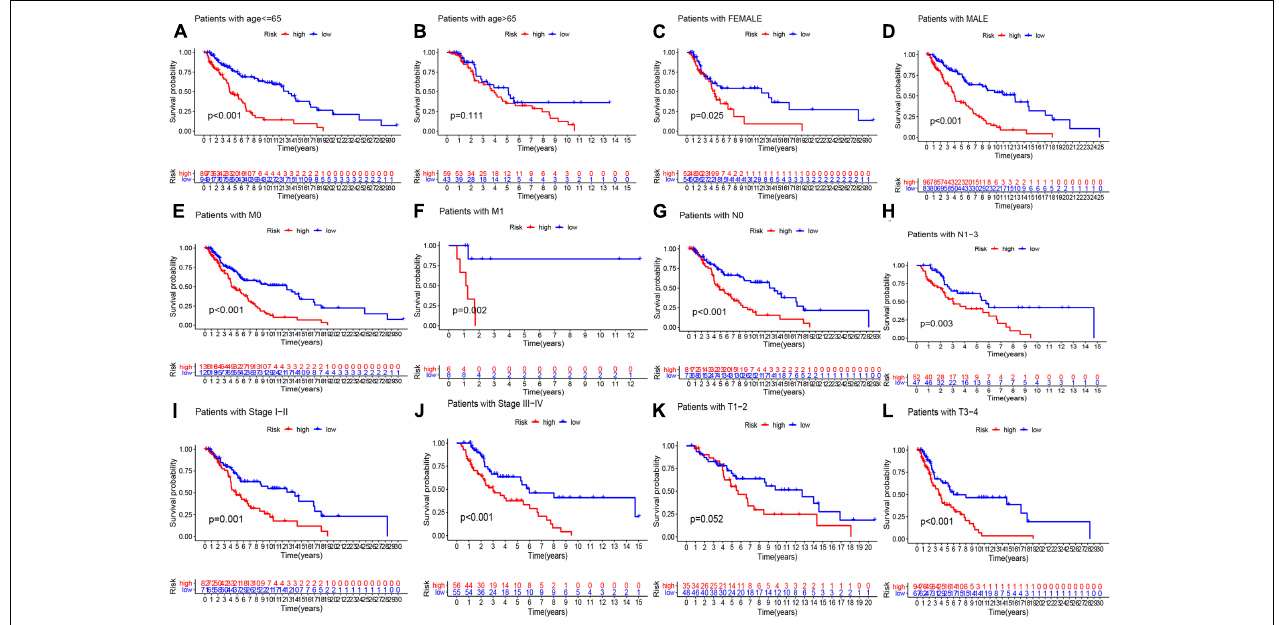
FIGURE 5 | K–M methods for the two risk group (high vs. low) categorized by clinical variables, comprising age (A,B) , gender (C,D) , M (E,F) , N (G,H) , stage (I,J) , and T (K,L) .